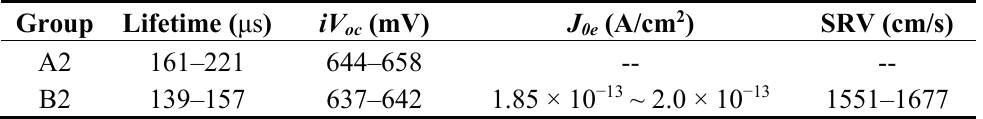
Table 3. Lifetime, iV oc , J 0e and SRV of Group A 2 and B 2 test samples from Figure